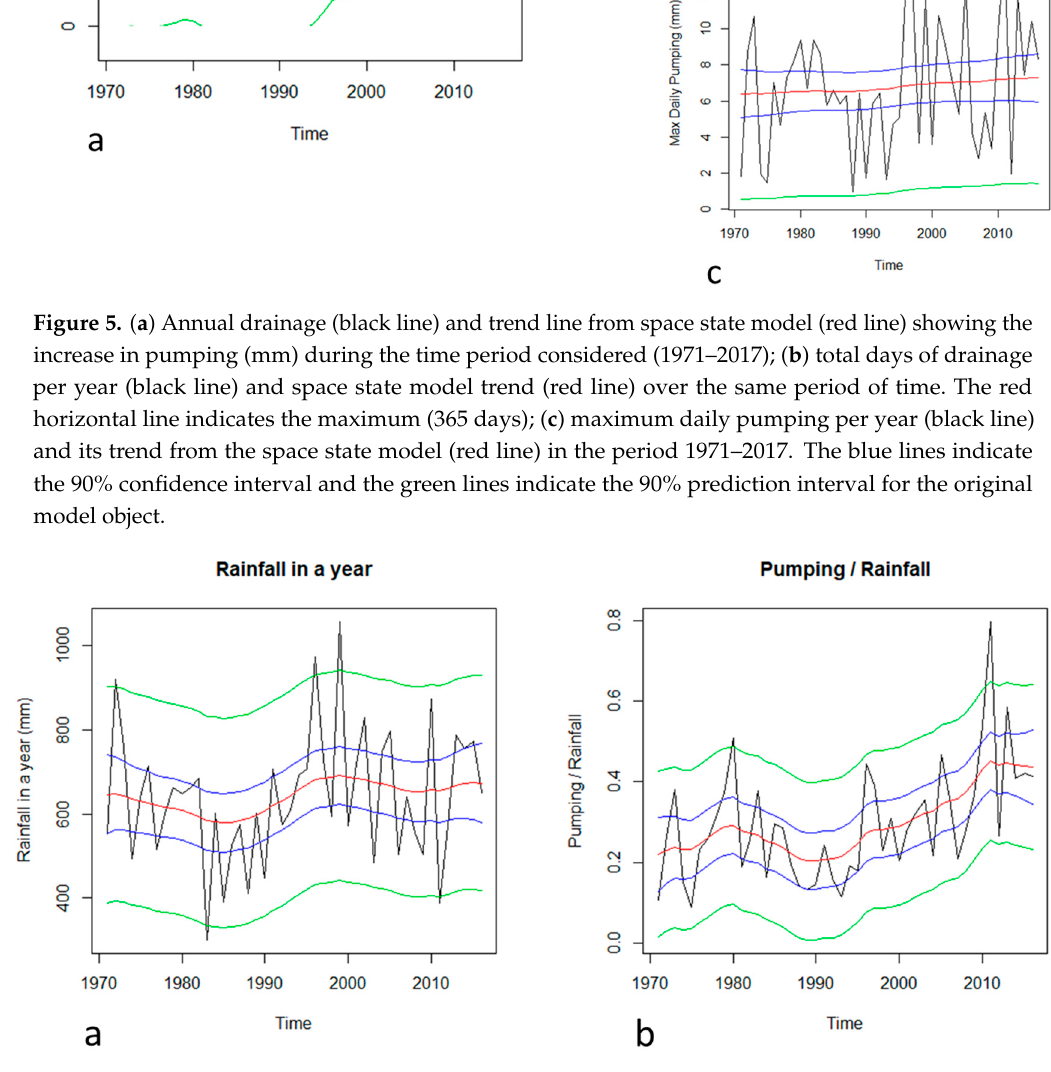
Figure 6. ( a ) Cumulative rainfall (mm / year, black line) and its trend obtained with the space state model (red line) during the time period considered (1971–2017); ( b ) Pumping-Rainfall ratio during the period 1971–2017 (black line) and its trend from the space state model (red line). The blue lines indicate the 90% confidence interval and the green lines indicate the 90% prediction interval for the original model object.